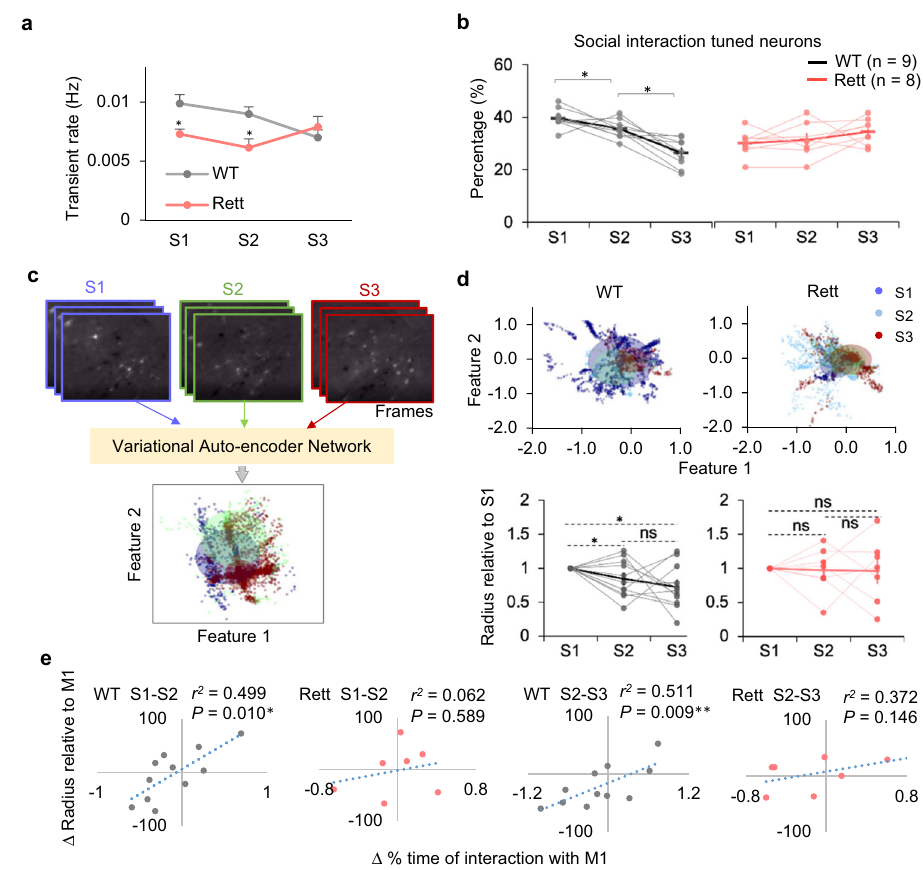
Fig. 3 Limited responsiveness and plasticity in the Rett mPFC circuit. a Transient rate changes of the mPFC neurons in the WT ( Mecp2 + / + ; n = 9) and Rett ( Mecp2 + / − ; n = 8) mice over three sessions of interacting with M1. Error bars indicate SEM. # P < 0.05, between genotypes, * P < 0.05, WT vs. Rett in each session. Two-way RM ANOVA with Bonferroni – corrected post hoc comparisons. b Percentage of recorded mPFC neurons activated during social interactions in WT ( n = 9) and Rett ( n = 8) mice in each session. Each dot indicates one mouse. Lines connect data from one mouse; thicker solid lines connect the averaged value from all the mice in each group. * P < 0.05, between sessions. Two-way RM ANOVA with Bonferroni – corrected post hoc comparisons. c The variational auto-encoder approach (VAE) transforms the coding information within each imaging frame into two features (1 and 2), represented by one dot in a two-dimensional plot. Frames recorded during social (M1) interaction periods over three sessions were transformed and their corresponding feature distributions were color-coded dark blue, light blue, and red, respectively. The circular shaded area represents the distribution radius (See Methods). d Top: Feature distributions of M1 interactions in S1, S2, and S3 from the representative WT and Rett mice. Bottom: changes of relative distribution radius (normalized to S1) responding to M1 interactions across three sessions of each WT ( n = 11) and Rett ( n = 7) mouse. Each dot indicates the normalized average value. Lines connect data from one mouse; thicker solid lines connect the averaged value from all the mice in each group. Error bars indicate SEM. * P < 0.05, ns, no signi fi cance. Two-way RM ANOVA with Bonferroni – corrected post hoc comparisons. e Correlation between changes in the duration of social interaction and relative radius between sessions (S1 – S2 and S2 – S3). Pearson ’ s correlations were calculated separately for WT (gray) and Rett (red) mice. Dots indicate individual mice. * P < 0.05, ** P < 0.01, regression. Source data are provided as a Source Data fi